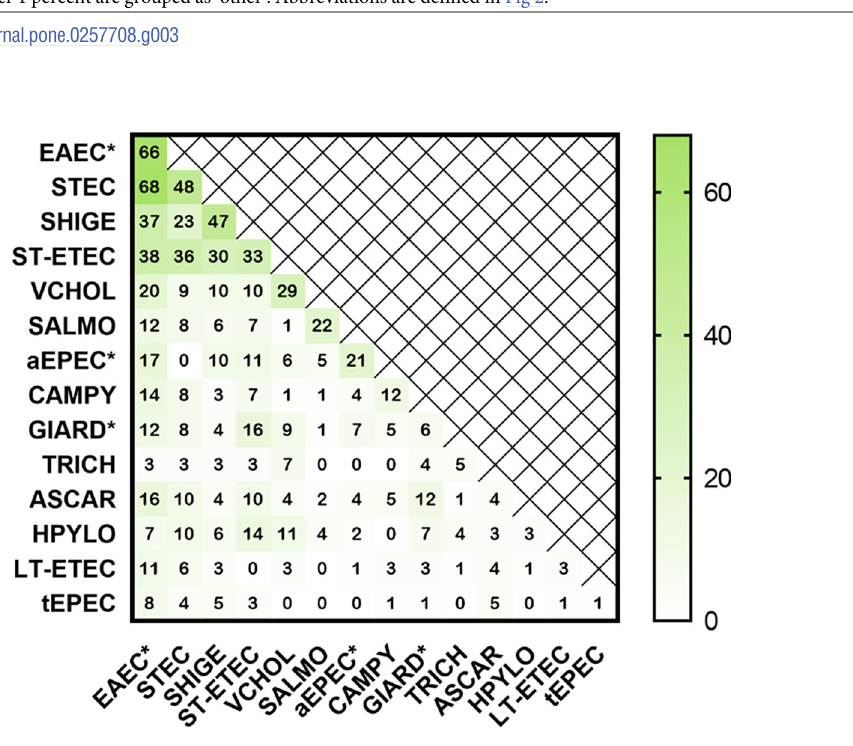
Fig 4. Distribution of co-infections. Data along the diagonal axis enumerate single pathogen detections. Shading represents the number of positive infections. Abbreviations are defined in Fig 2. Asterisks demarcate non-etiologic